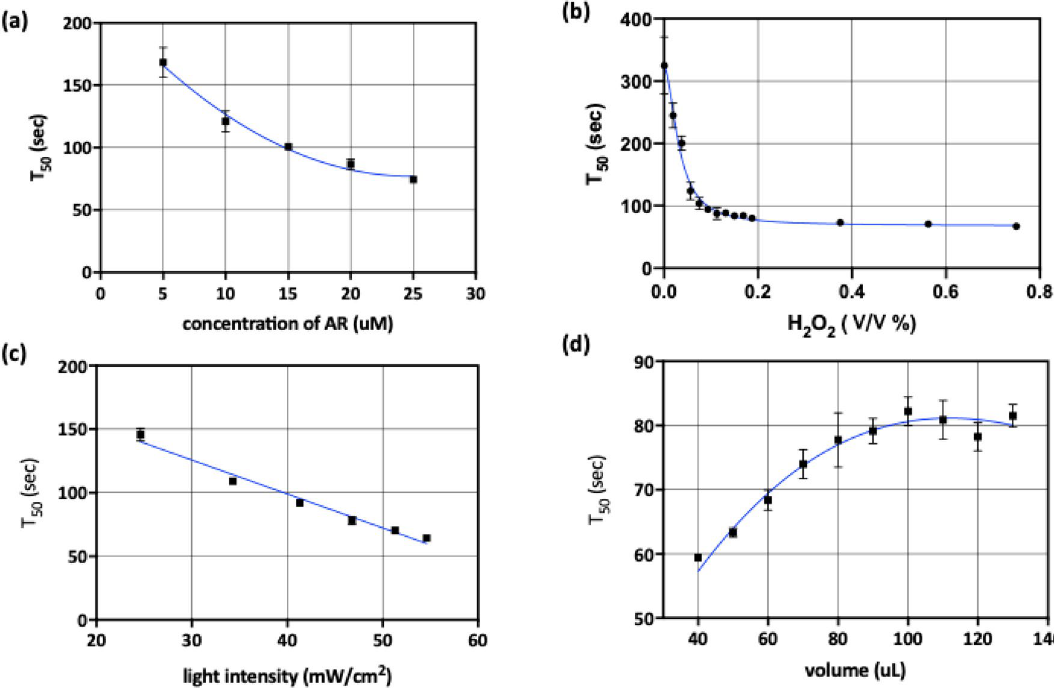
Figure 4. Effect of reaction environmental factors on half-maximum time in PIFA assay ( a ) ADHP concentration (5, 10, 15, 20 and 25 μM) is inversely proportional to half-maximum time ( b ) hydrogen peroxide concentrations (0 ~ 0.75%) is highly nonlinear with half-maximum time and the effect is limited over 0.1% ( c ) light intensity (25 ~ 55 mW/cm 2 ) is negatively linear with half-maximum time ( d ) volume of mixture is proportional to half-maximum time and saturated when it is over 90